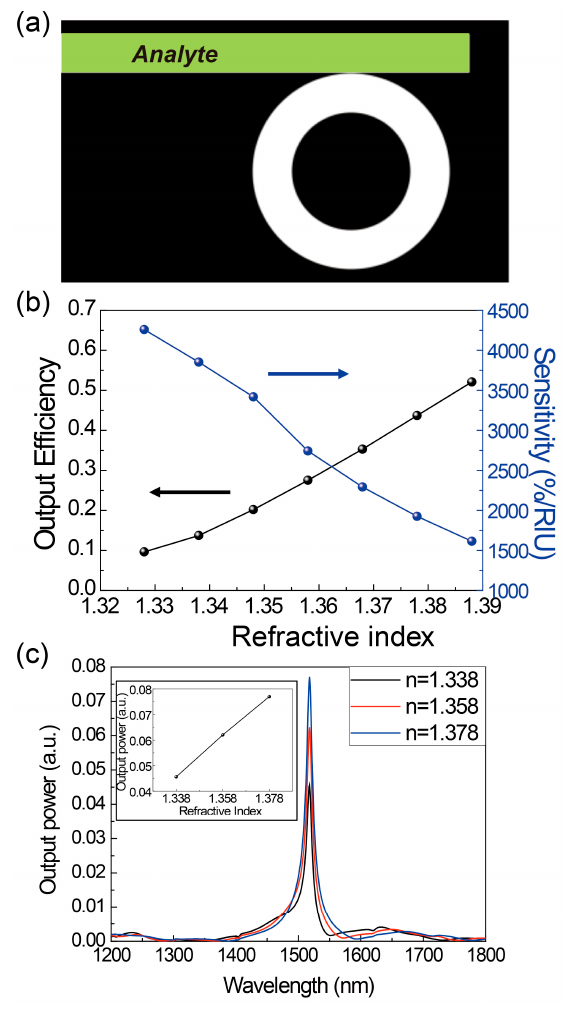
Figure 4. ( a ) A schematic diagram of the refractive index sensor that uses the proposed ring cavity system. The waveguide is filled with an analyte with a measurable refractive index. ( b ) The output efficiency (black) and normalized intensity sensitivity (blue) as a function of the refractive index to be measured. ( c ) The output power spectrum of a broadband dipole emitter for different refractive indices of the analyte: 1.338 (black), 1.358 (red), and 1.378 (blue). The dipole emitter is placed at one of the antinodes of the ring cavity. The inset shows the peak output power as a function of the refractive index.